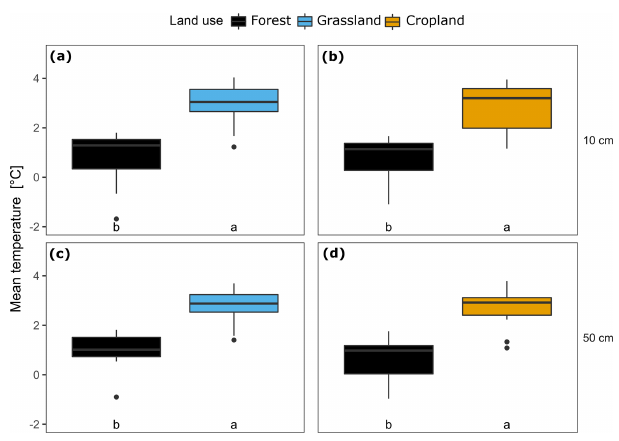
Figure 3. Tukey-style boxplot of the mean temperature in grassland–forest pairs ( n = 9) (a, c) and cropland–forest pairs ( n = 12) (b, c) at 10 (a, b) and 50cm (c, d) depth. Different letters at the bottom of each panel indicate statistically significant differences in mean temperature based on estimated marginal means at a level of significance of α = 0 . 05 ( p< 0 . 05). Interactive effects between land use and depths were not significant.